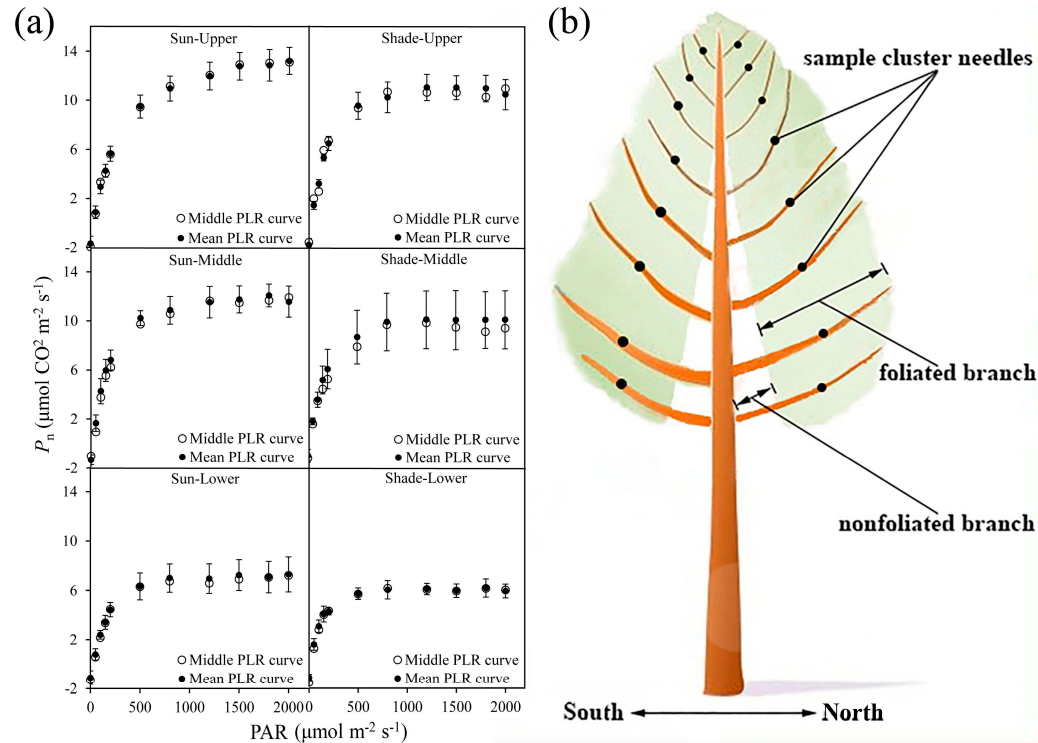
Figure 1. Positions of needle cluster samples within the crown. ( a ) Comparison between the PLR curve in the middle of the foliated branch and the average PLR curve throughout the entire foliated branch. P n and PAR represent the net photosynthetic rate ( μ mol m − 2 s − 1 ) and the photosynthetically active radiation ( μ mol m − 2 s − 1 ), respectively; unfilled circles represent the PLR curve in the middle of the foliated branch, and filled circles represent the mean values of all PLR curves of the branch; and solid bars represent the standard deviation. ( b ) A diagram of the positions of needle cluster samples within the crown. PLR, photosynthetic light response; PAR, photosynthetically active radiation; P n , net photosynthetic rate.